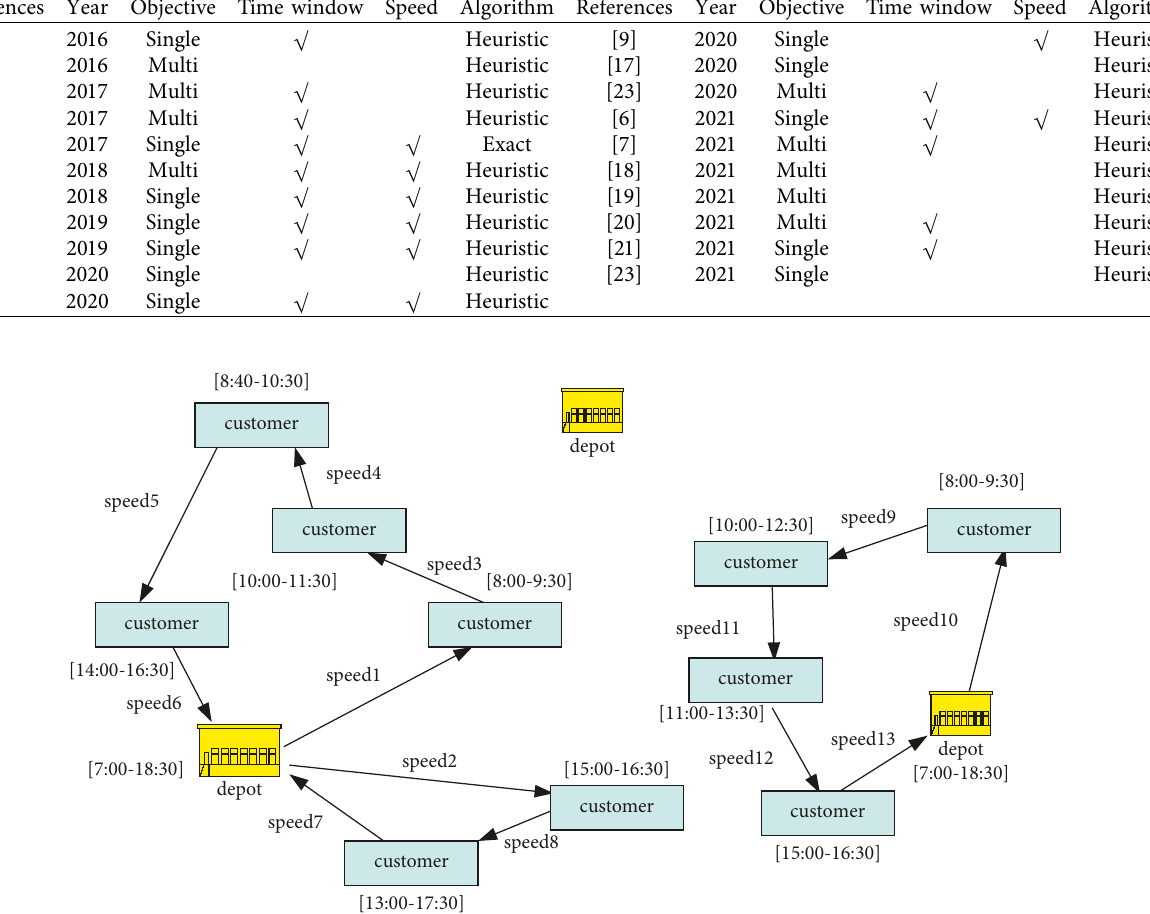
Table 1: The papers on GLRP.